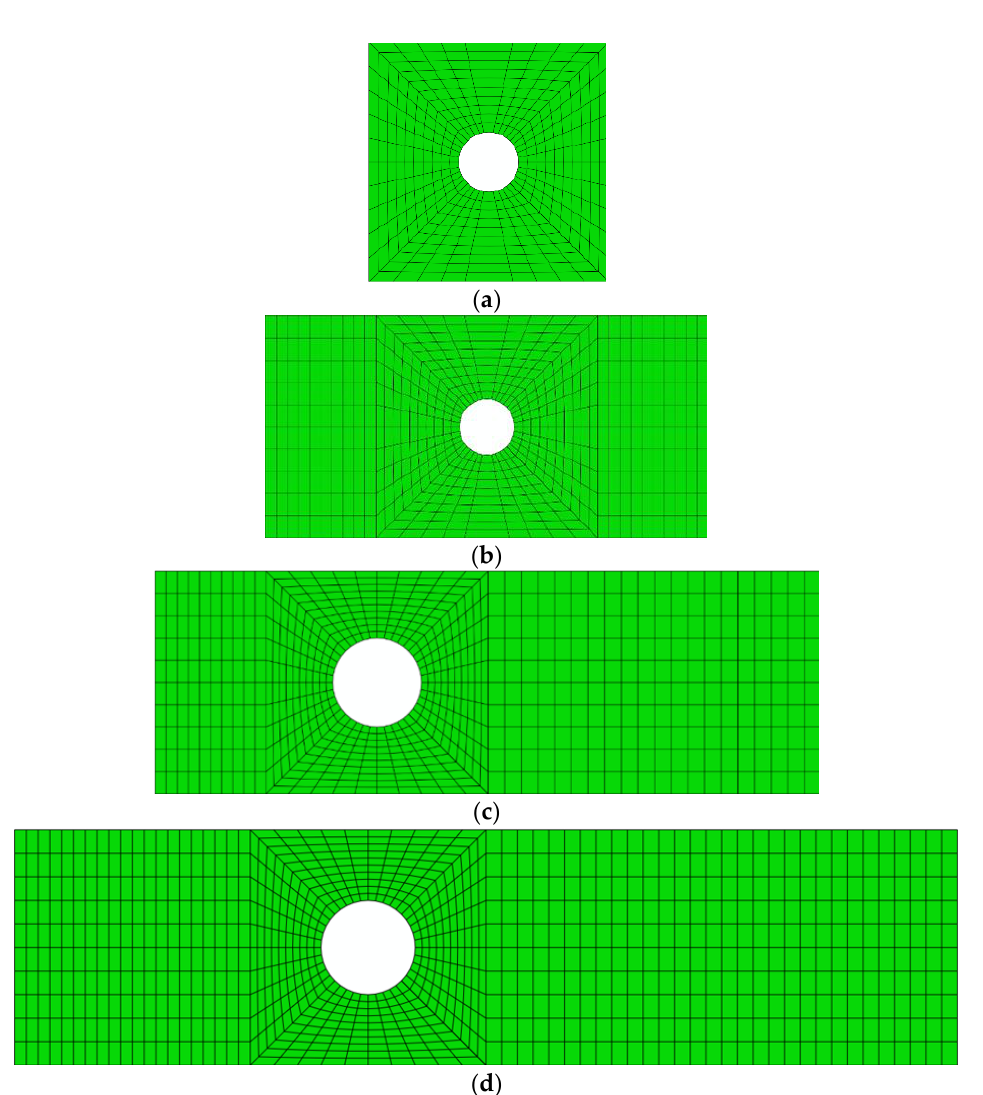
Figure 8. Examples of four typical plate models’ meshes. ( a ) case of β = 1; ( b ) case of β =2; ( c ) case of β = 3; ( d ) case of β = 4.